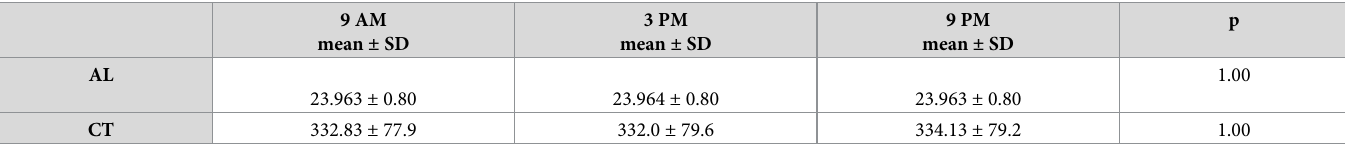
Table 4. Mean axial length and subfoveal choroidal thickness with standard deviation at the corresponding time of measurement and respective p-values showing no statistically significant diurnal changes.